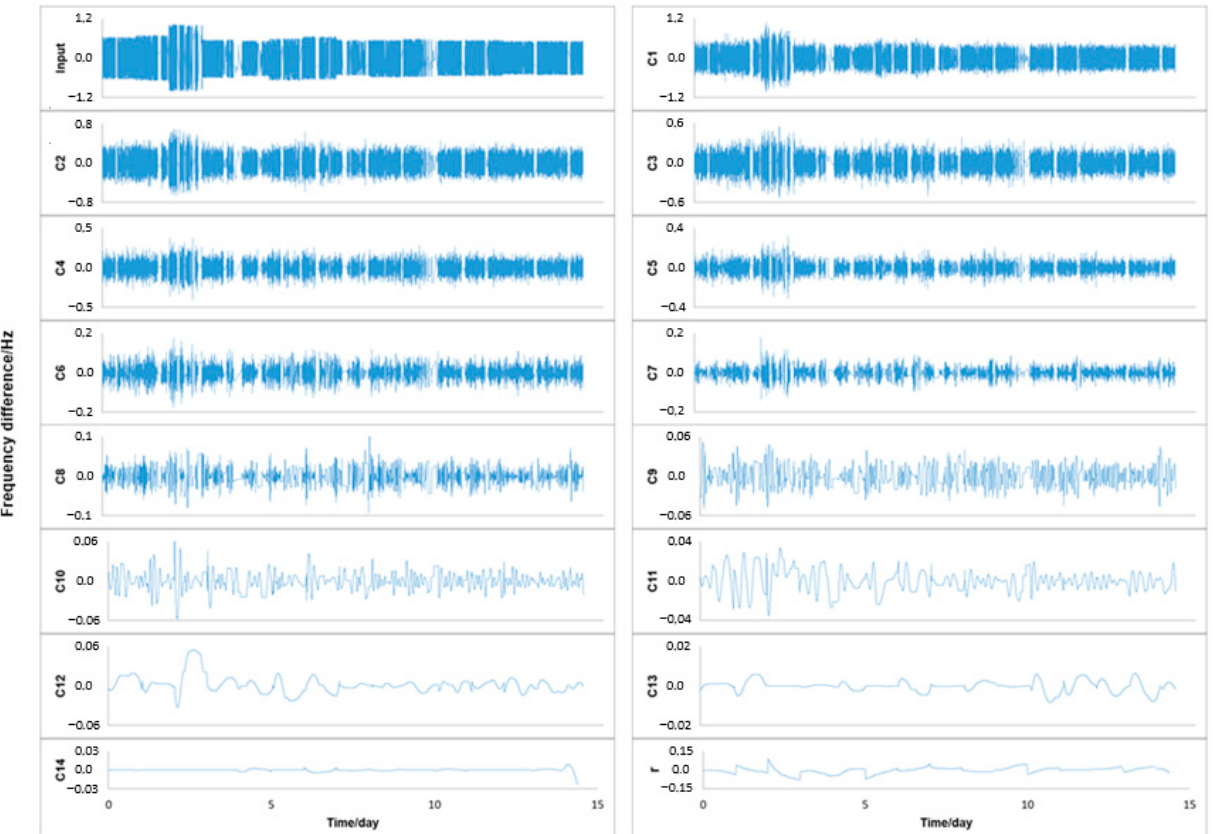
Figure 6. EEMD processing of the residual data series of the frequency difference between two optical clocks located at the same site. The input data (the first panel ), its intrinsic mode functions ( C1 )–( C14 ), and the trend of ( r ).